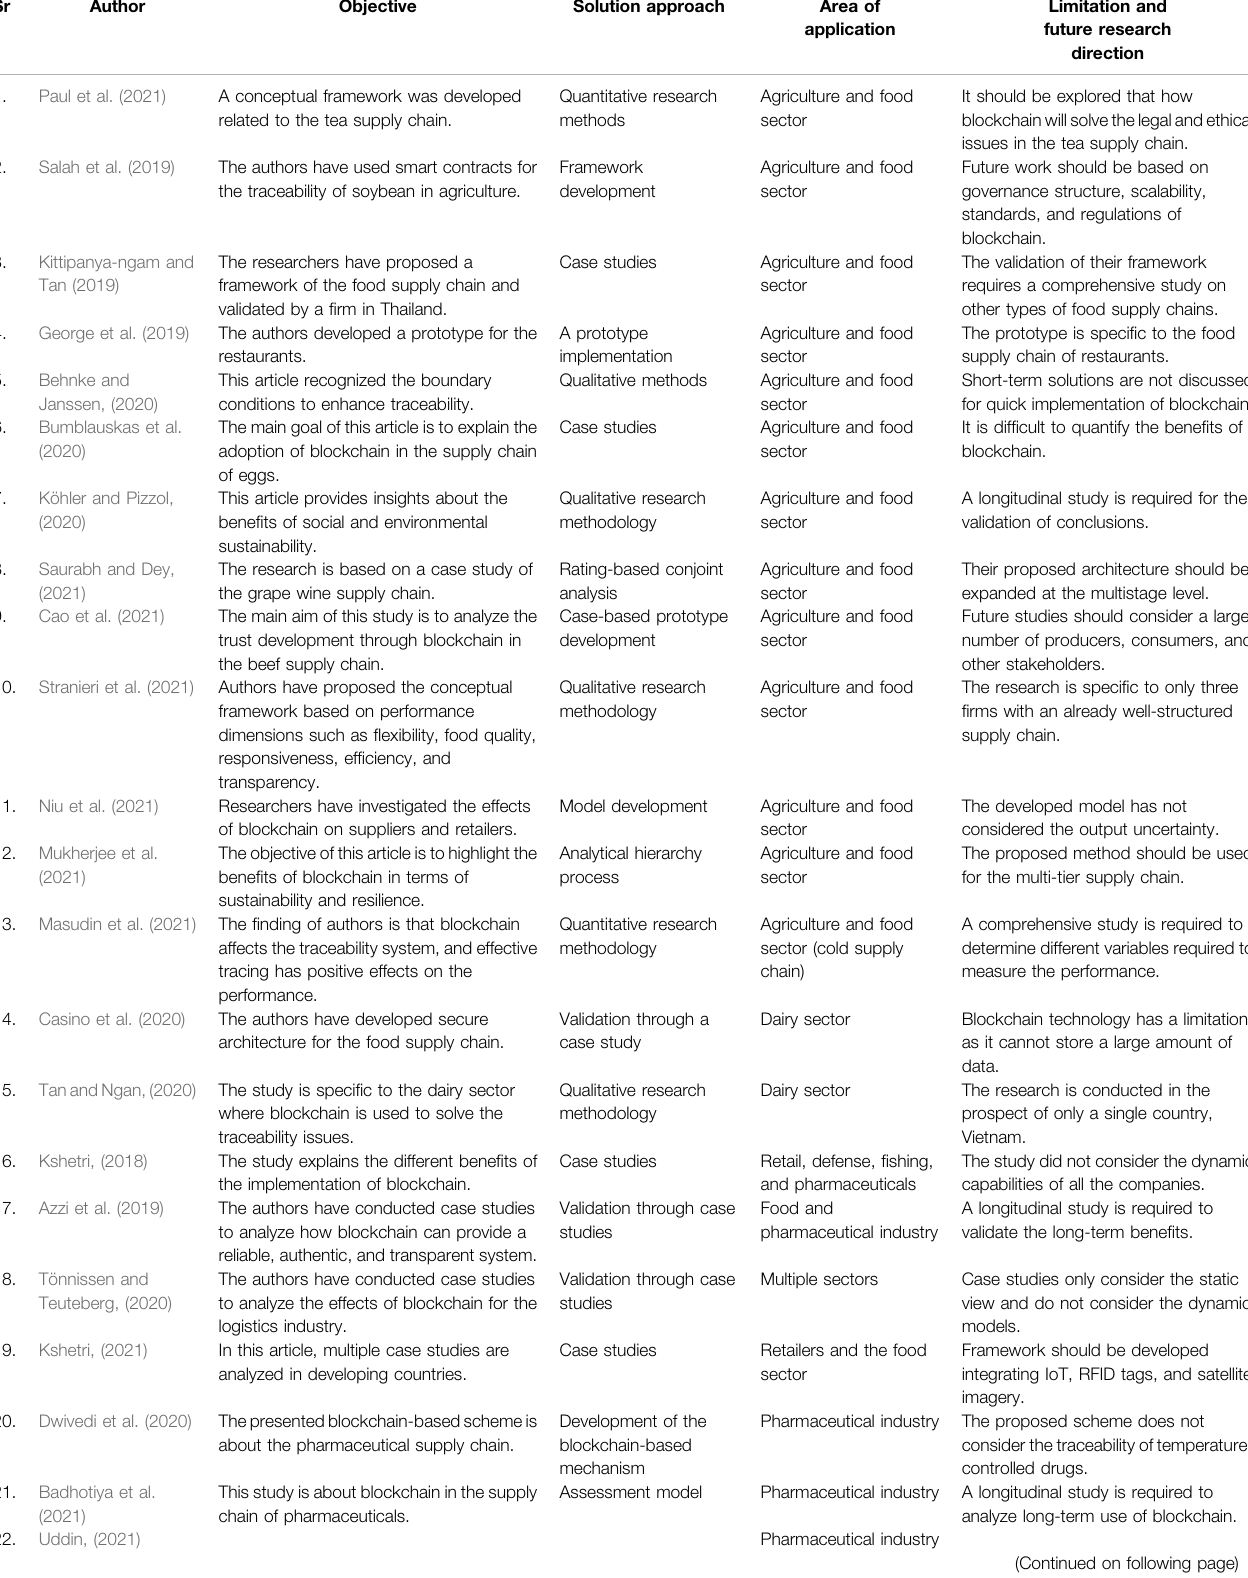
TABLE 3 | Case studies related to economic sustainability in the blockchain-based supply chain in agriculture, food, and healthcare